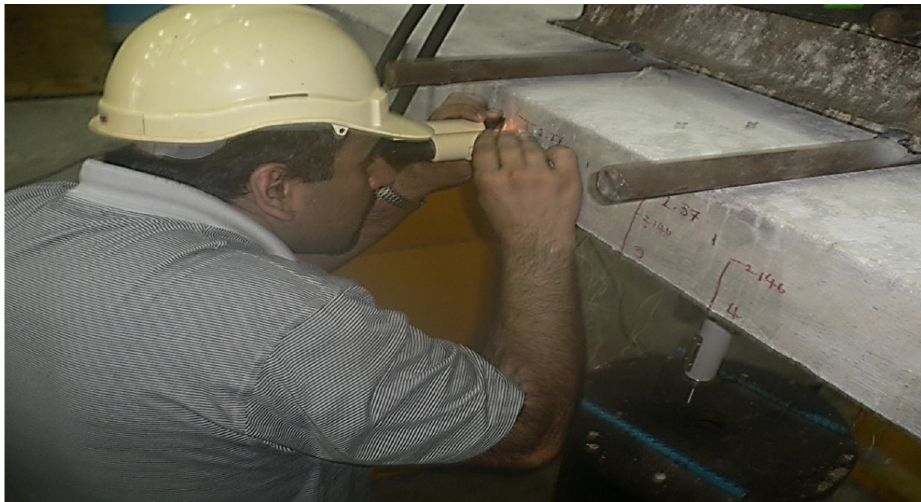
Figure 10. Crack measurement in each stage of the applied load. Table 8. Experimental versus analytical results for estimating first crack moment and crack width.